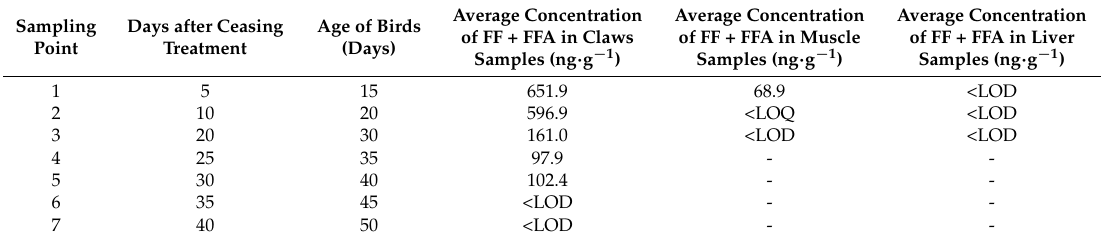
Table 1. Depletion of florfenicol (FF) and florfenicol amine (FFA) in claws, muscle, and the liver of broiler